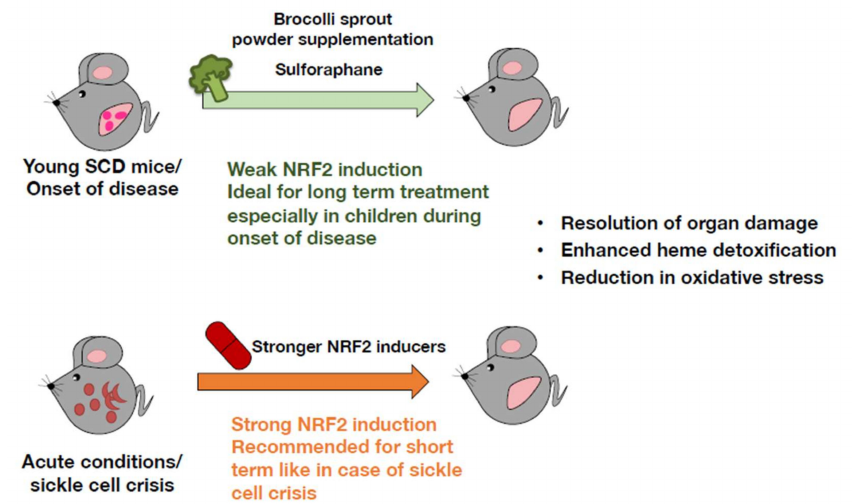
Figure 9. Use of NRF2 inducers as a treatment strategy for ameliorating sickle cell disease (SCD) pathology. Sulforaphane is found abundantly in cruciferous vegetables and is available as a food supplement. Because it is a mild NRF2 activator, it can be administered for a long time without causing toxicity. Therefore, it is an ideal treatment, particularly for young SCD patients upon disease onset. However, during acute conditions such as sickle cell crisis, a stronger NRF2 inducer is recommended to induce high NRF2